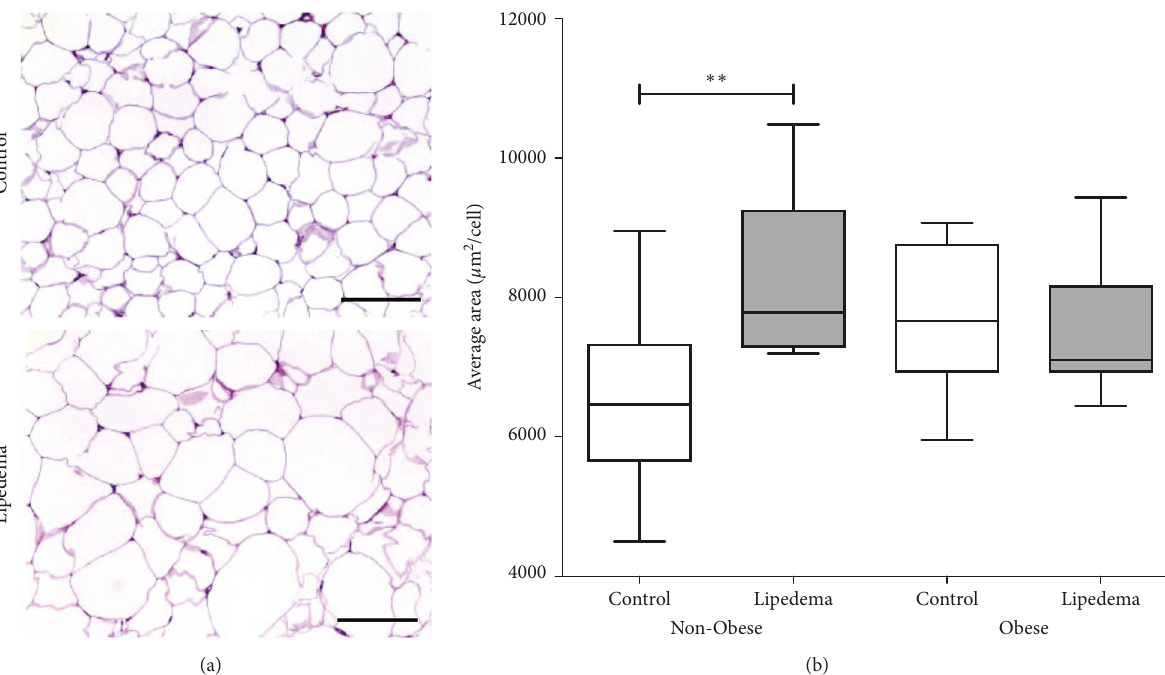
Figure 1: Adipocyte area measured in Non-Obese and Obese participants with and without lipedema (controls). (a) Representative H&E images showing heterogeneity and hypertrophy in cell size in adipocytes in leg fat of Non-Obese participants (scale bar and whisker plot representing the average adipocyte area in Non-Obese (Control n n 9; Lipedema n 11) (cid:31) (cid:31)